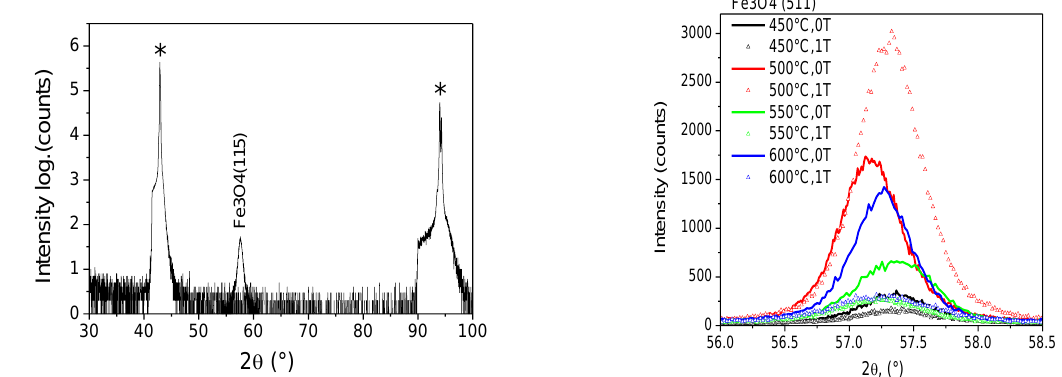
Figure 3. ( Left ) Typical XRD pattern of a Fe 3 O 4 film on a MgO(100) substrate. ( Right ) Fe 3 O 4 (511) reflections for the films grown at different temperature in and without external magnetic field (*-MgO substrate peaks).